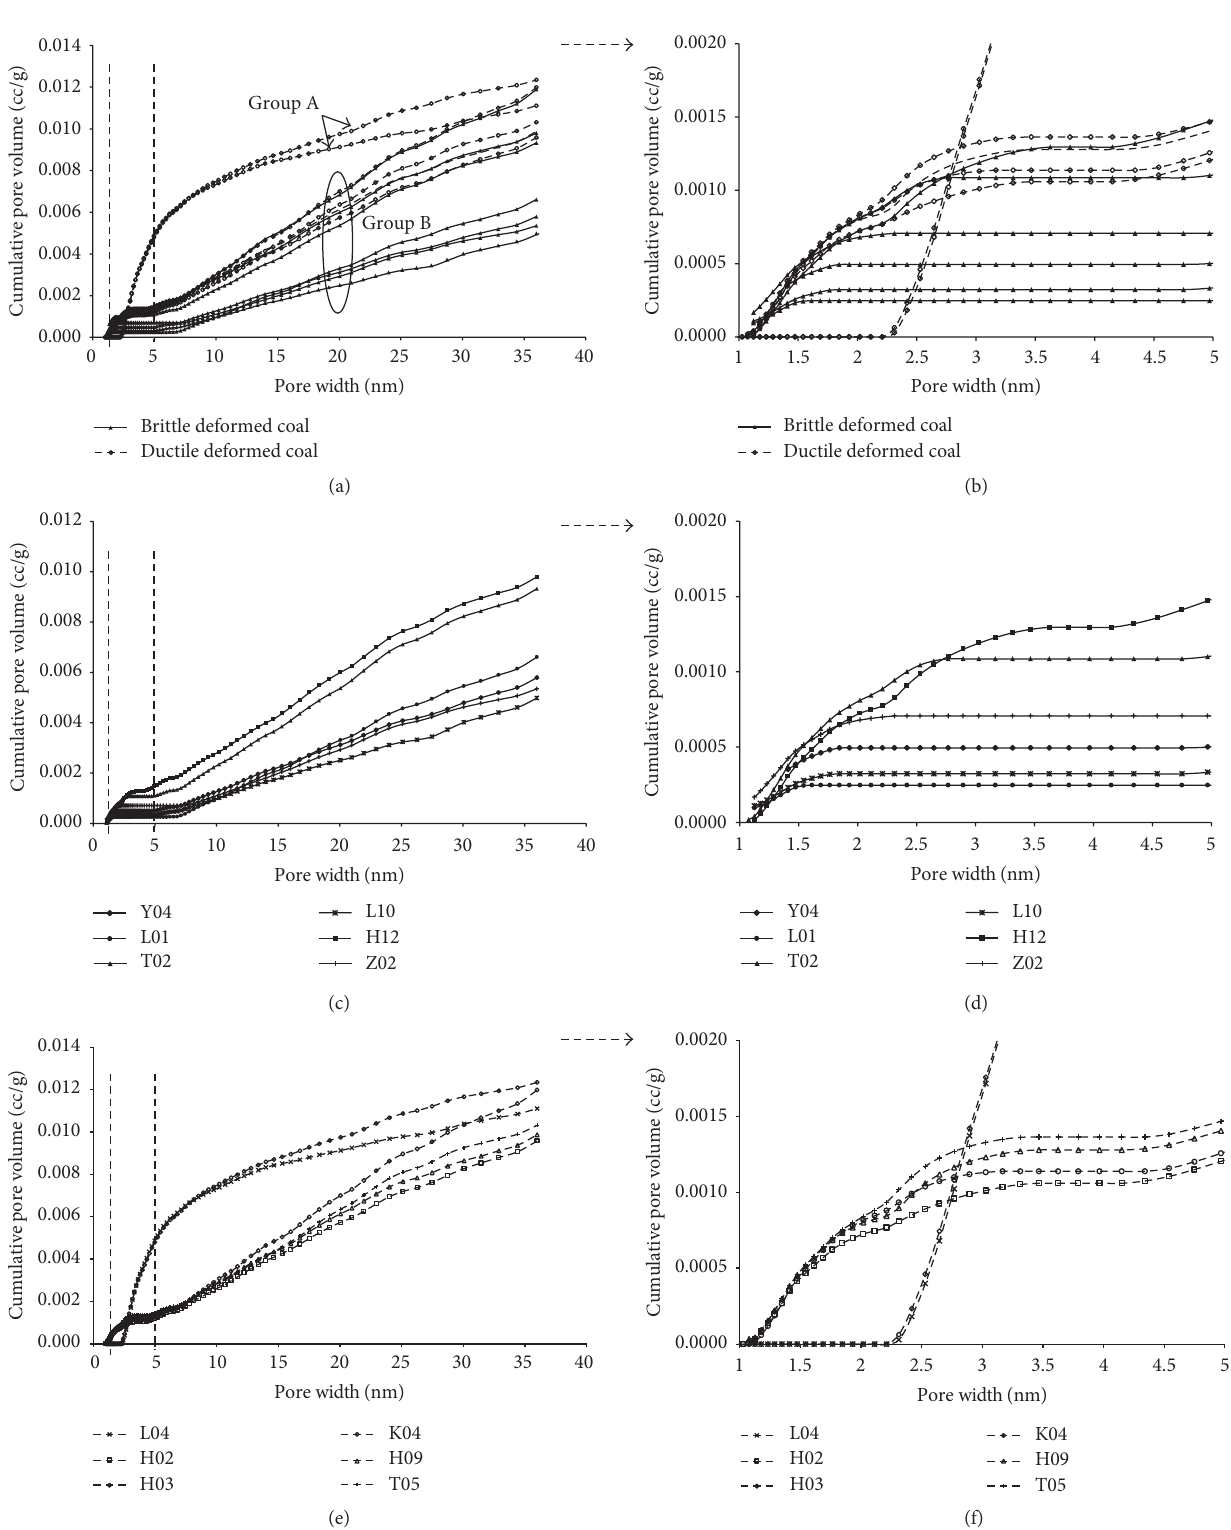
Figure 5: Relationship between cumulative pore volume and pore width of deformed coal (a-b); (c, d) brittle deformed coal; (e, f) ductile deformed